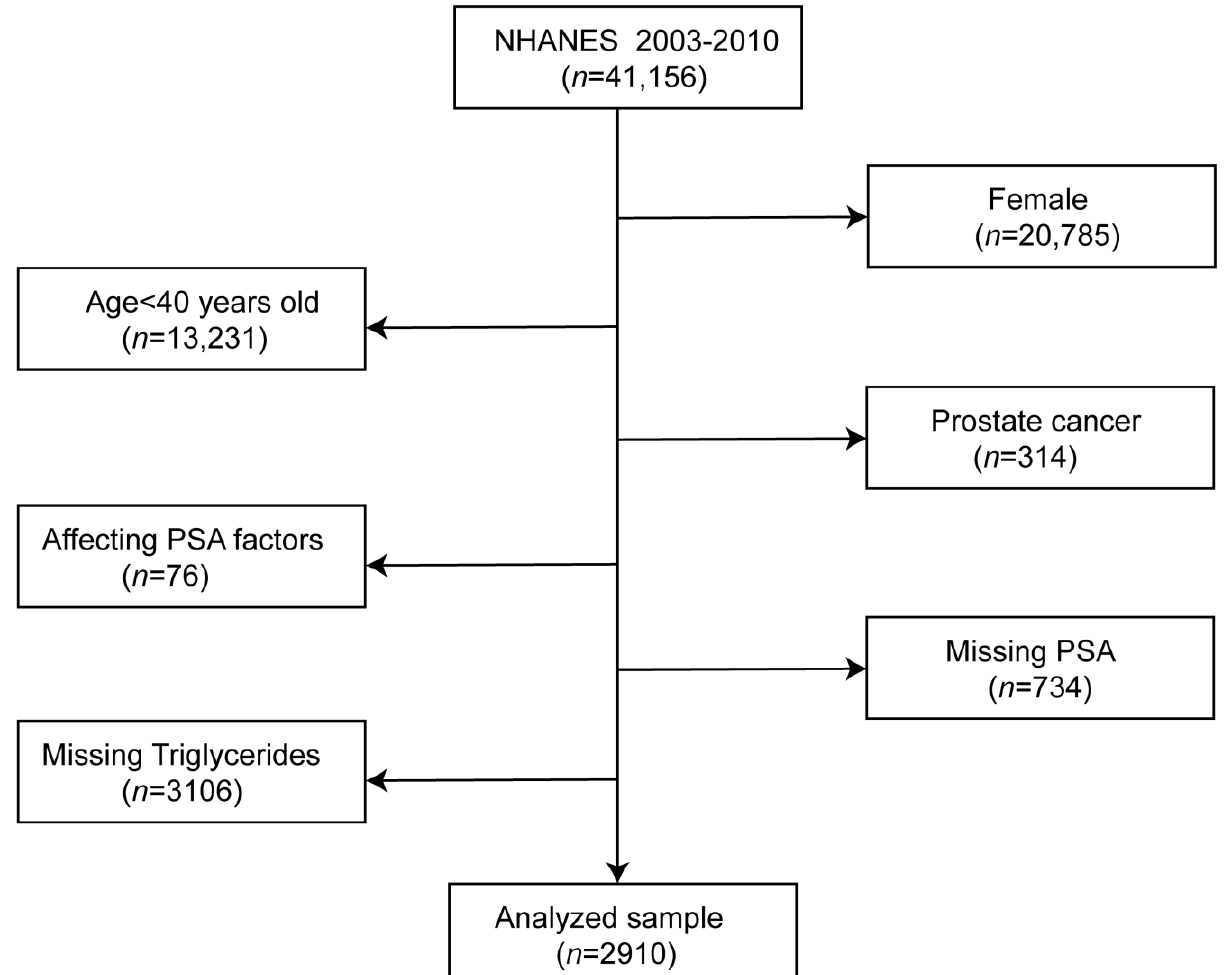
Figure 1. Flowchart in selecting the studying participants.